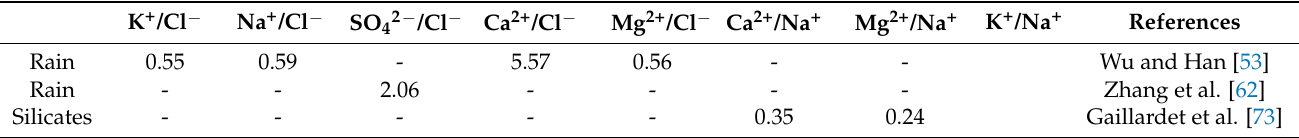
Table 4. Ratio of different end-members used in the